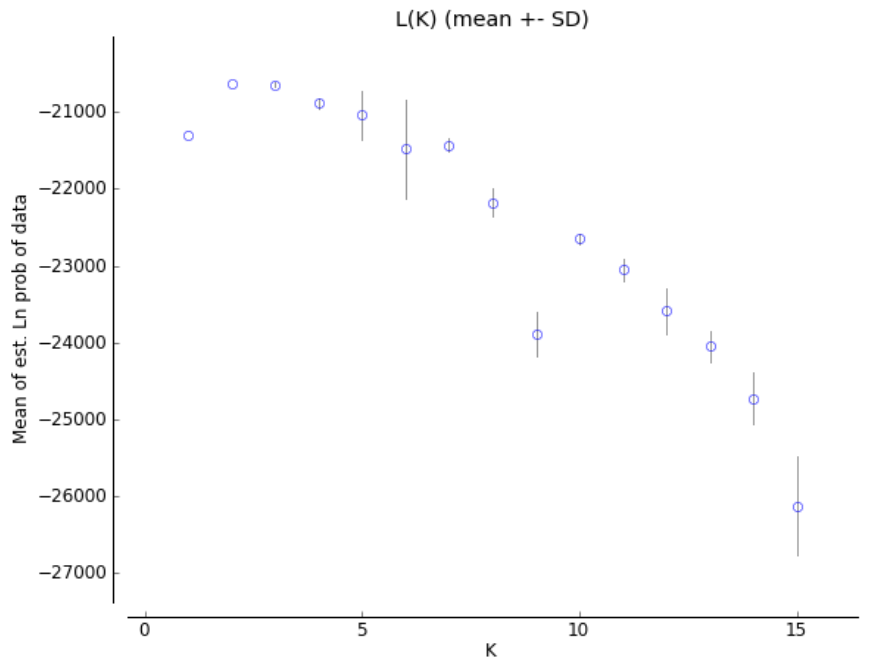
Figure A2.2. Mean likelihood for each K plus standard deviation as retrieved from Structure Harvester v0.6.94 (Earl and vonHoldt